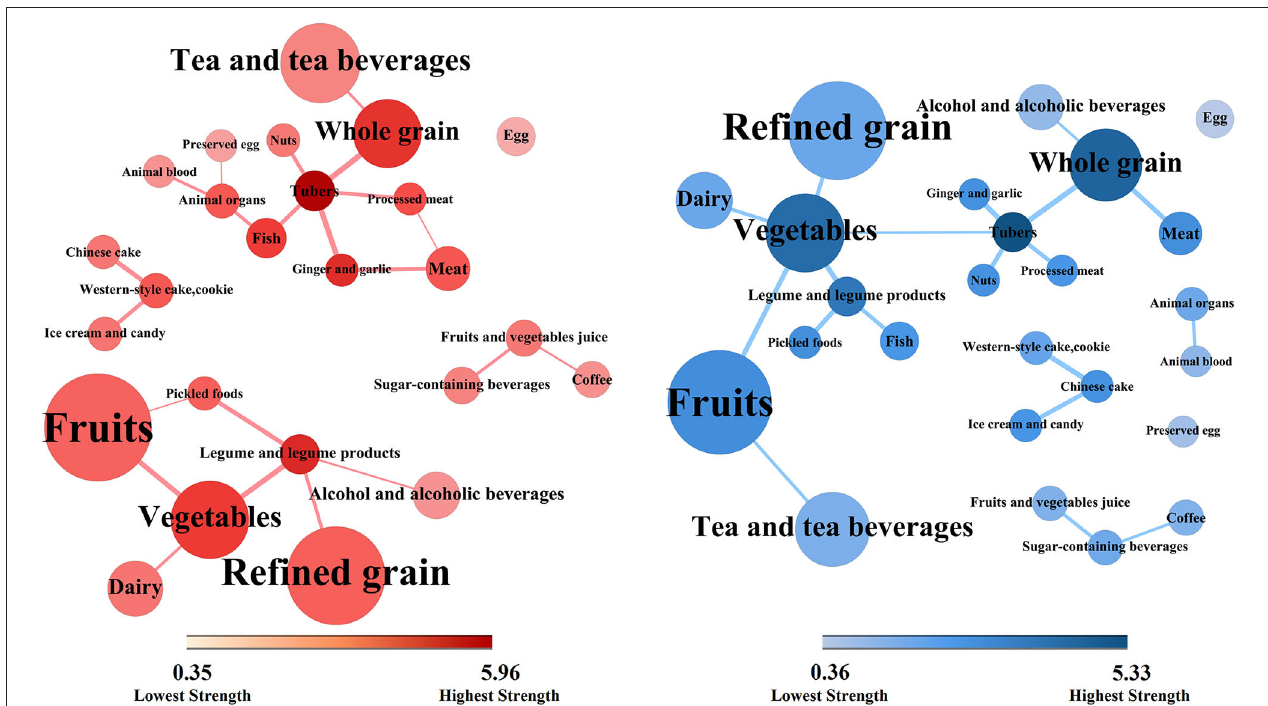
FIGURE 2 | Dietary topologies among cases of non-alcoholic fatty liver disease (red) and matched controls (blue). Dietary topologies computed separately among cases of non-alcoholic fatty liver disease (red) and matched controls (blue) using mutual information. Edge width sets proportional to the weights of connections (for better interpretability, plots are limited to edges with inferred weight 0.30), and node size sets proportional to the absolute intake of each corresponding food group, ≥ where the colors from light to dark were proportional to the strengths of each